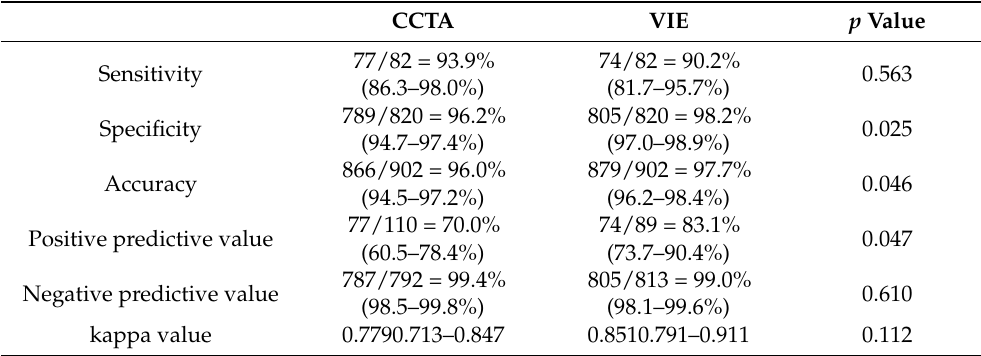
Table 1. Diagnostic performance of CCTA versus VIE in detecting either in-stent restenosis or coronary artery disease in 902 vessel segments with stents or plaques, using ICA as the gold standard. CCTA VIE p Value